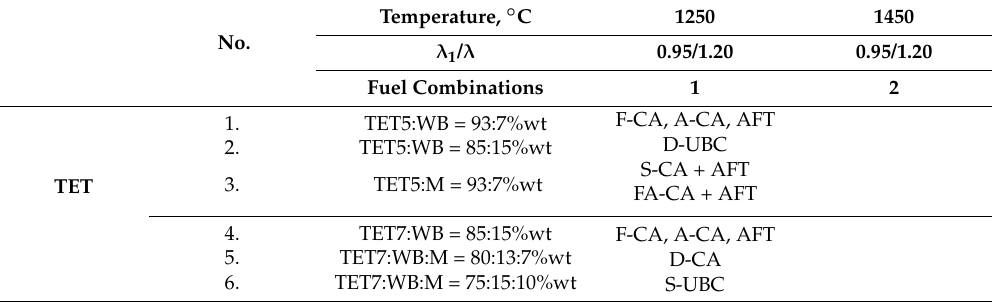
Table 1. Fuel test matrix, temperatures and air ratio used, scope of chemical analyses performed.